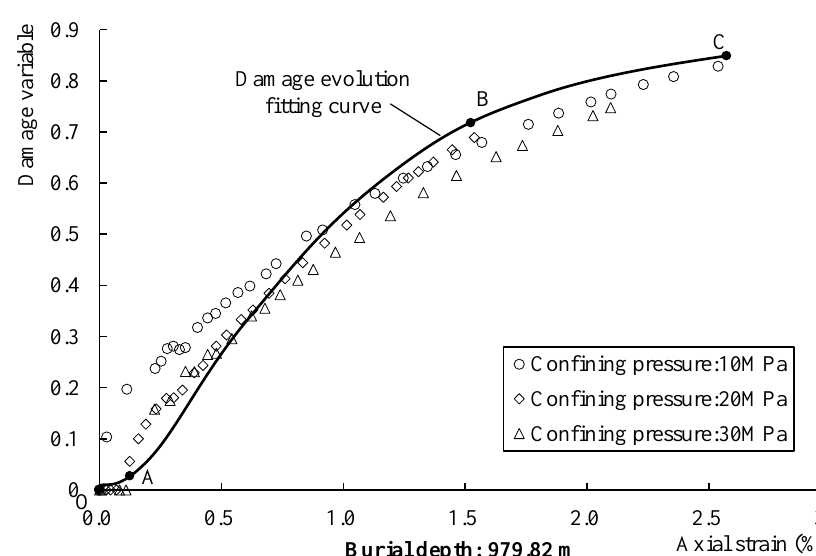
Figure 7. Damage evolution of clastic sandstone under different confining pressures.